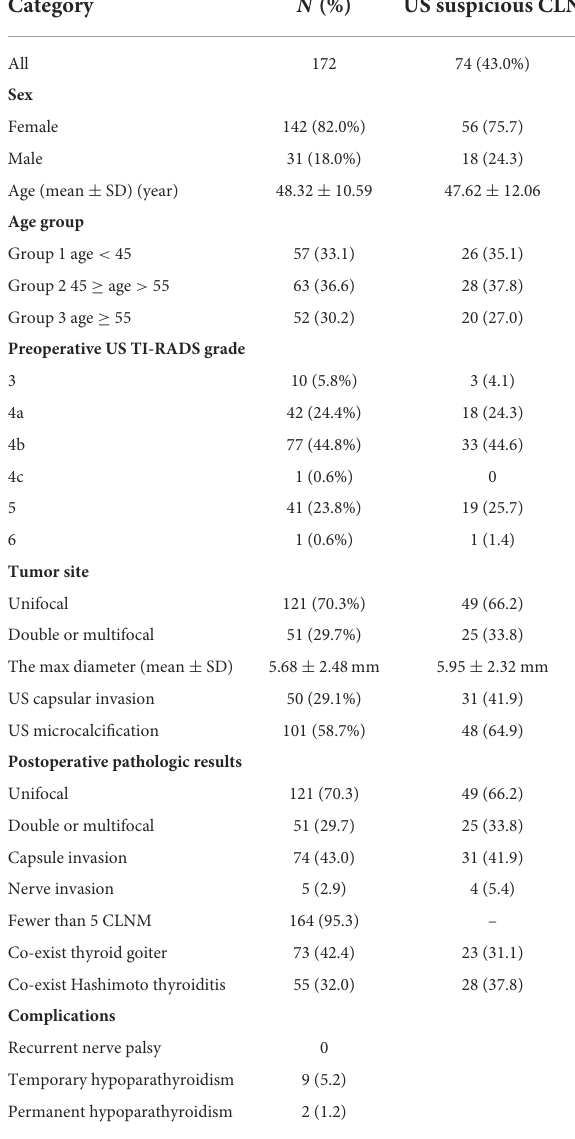
TABLE 2 Statistical data of the patients with central cervical lymph nodes metastasis